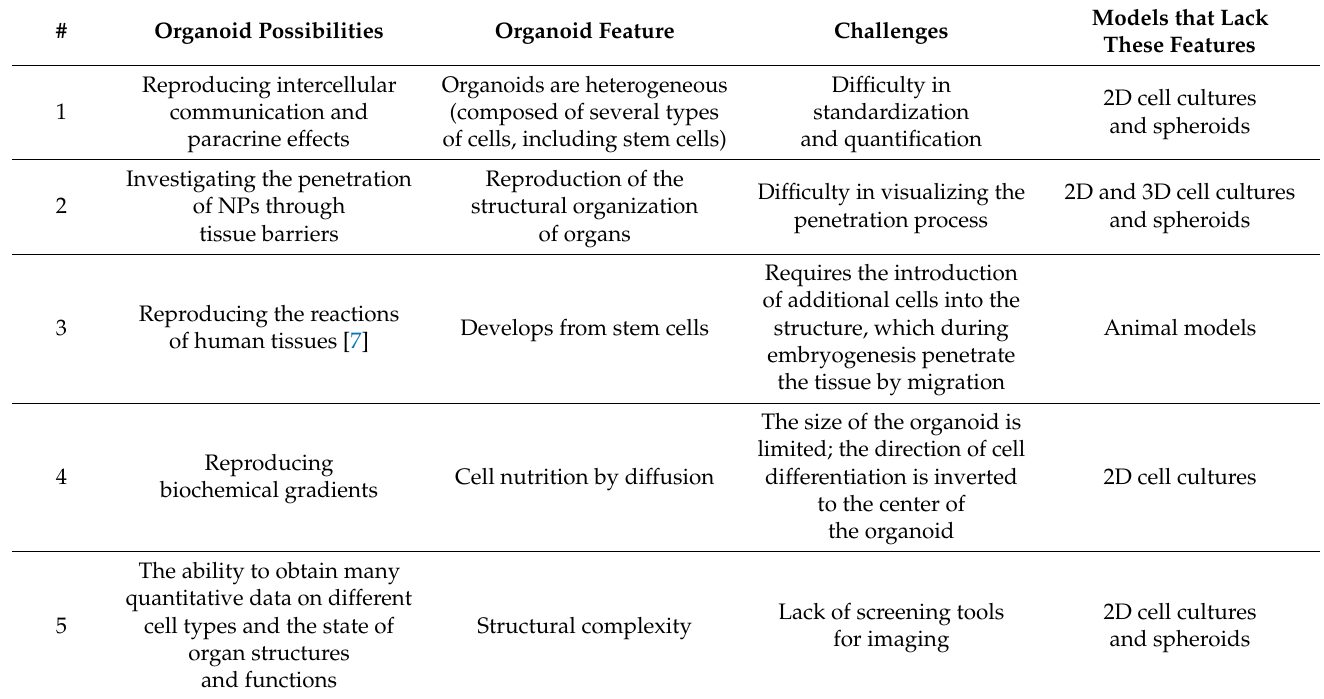
Table 3. Advantages and difficulties of using organoids in nanotoxicological